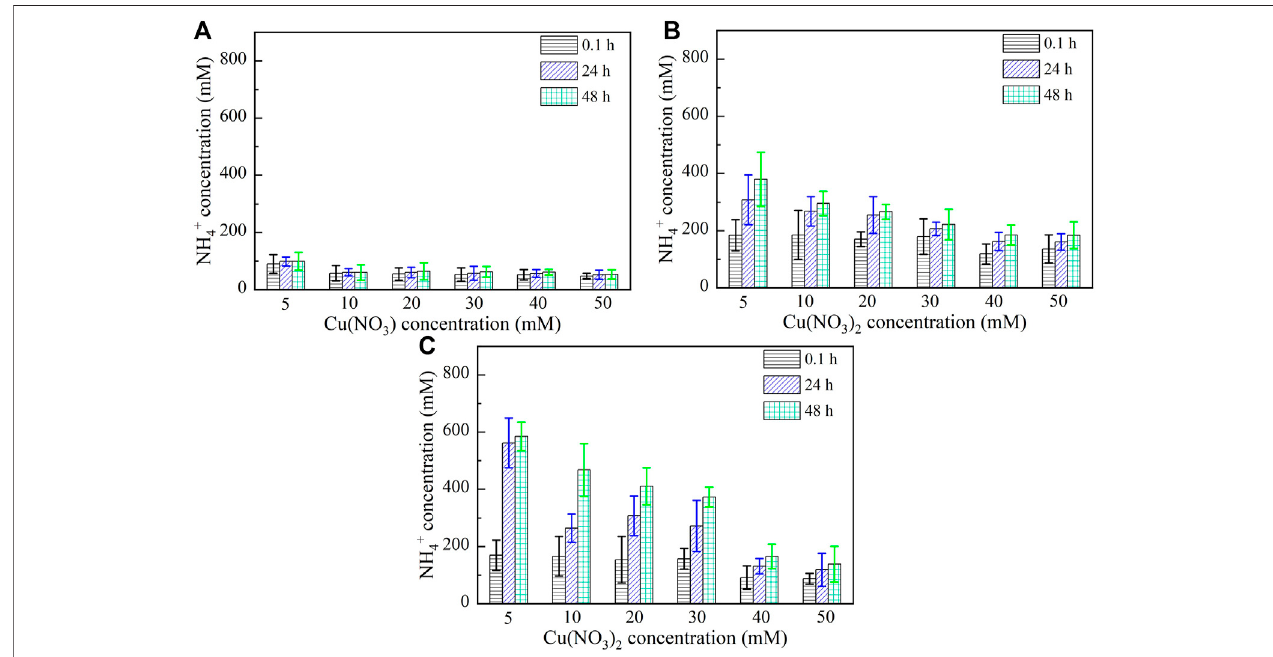
FIGURE6| RelationshipsofNH 4+ concentrationversusCu(NO 3 ) 2 concentration: (A) withoutyeastextract and CaCl 2 , (B) undertheeffectofyeastextract, and (C) under the effect of yeast extract and CaCl 2 addition.